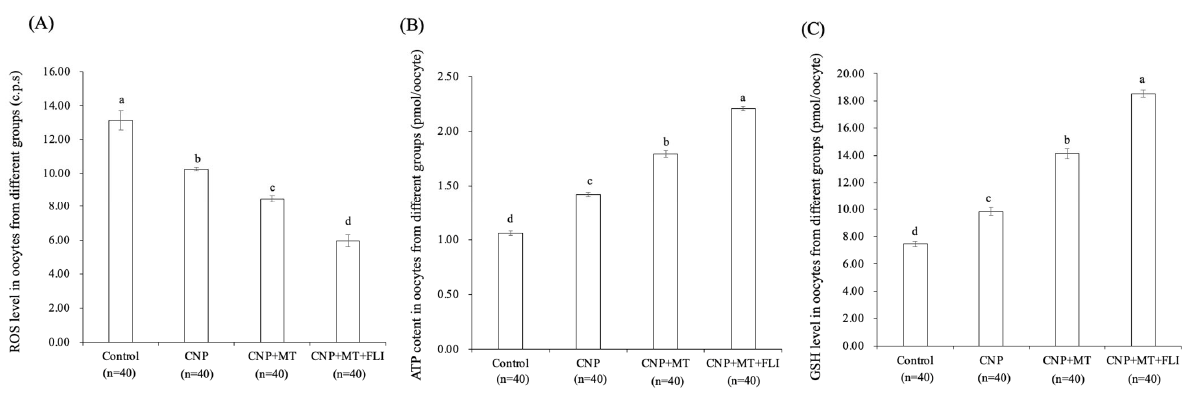
Figure 2. E ff ect of the combination treatment CNP, MT, and FLI on the ROS, ATP, and GSH levels in bovine oocytes. ( A ) E ff ect of CNP, MT, and FLI on ROS level in bovine oocytes. ( B ) E ff ect of CNP, MT, and FLI on ATP content in bovine oocytes. ( C ) E ff ect of CNP, MT, and FLI on GSH level in bovine oocytes. a, b, c, d Values with different superscripts indicate significant differences between groups ( p <